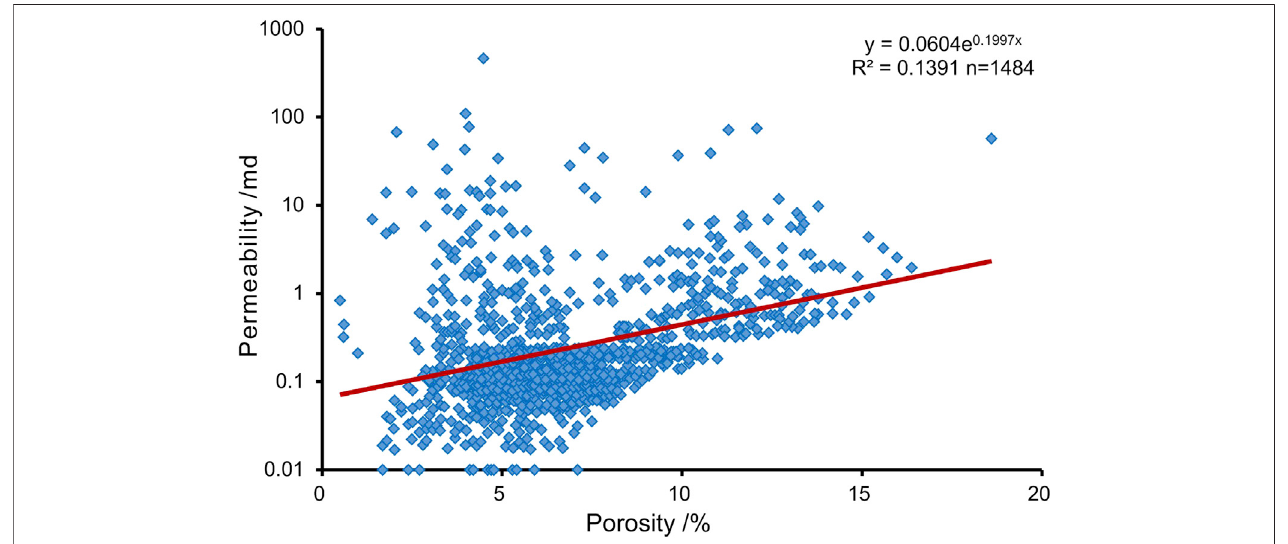
FIGURE 5 | Cross plot of porosity and permeability of Kepingtage